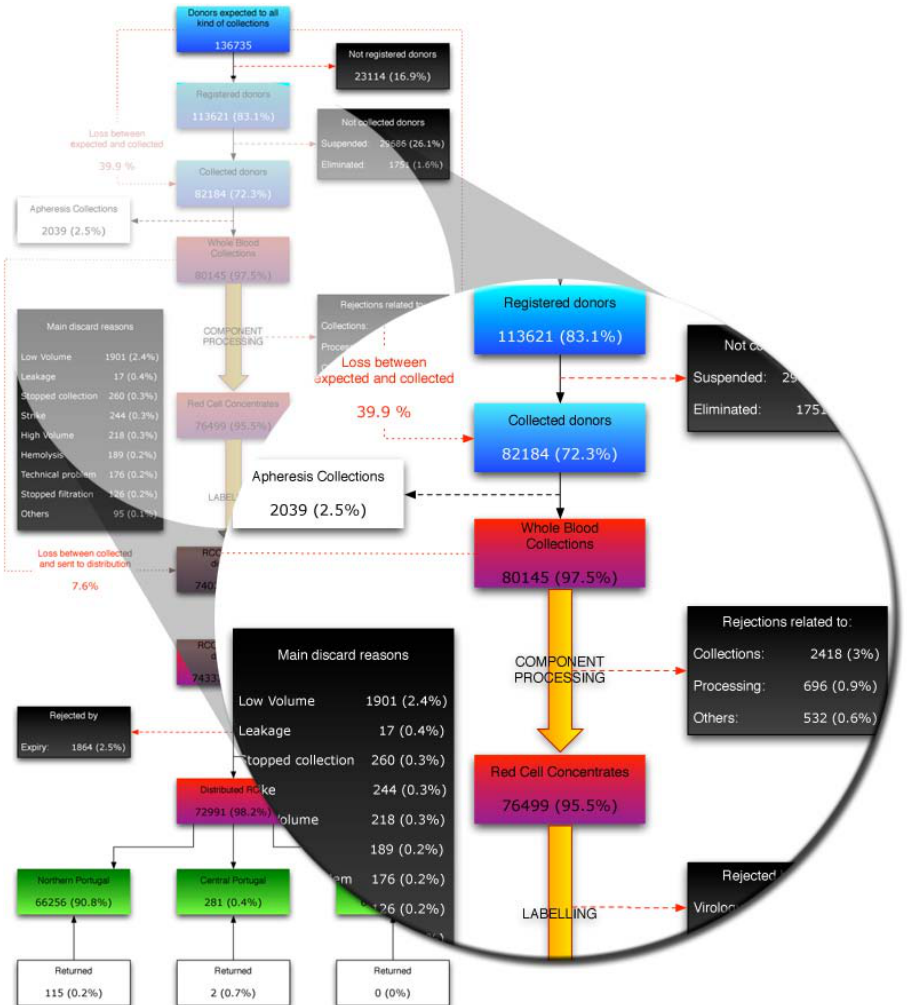
Figure 5: SAD_BaSe Flowchart. The zoom is set on the losses after component processing. In this example, from a total of 80145 Whole Blood Units, 95.5% of were processed into Red Cell Concentrates 3% discarded by collection-related problems, 0.9% discarded by Processing issues and 0.6% by other